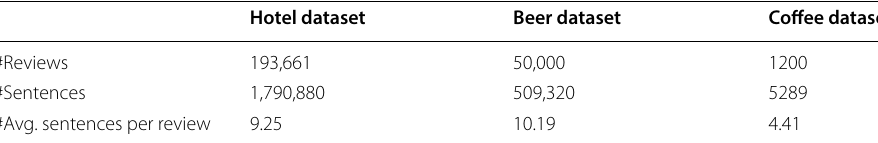
Table 3 Summary of the Data Set Hotel dataset Beer dataset Coffee dataset